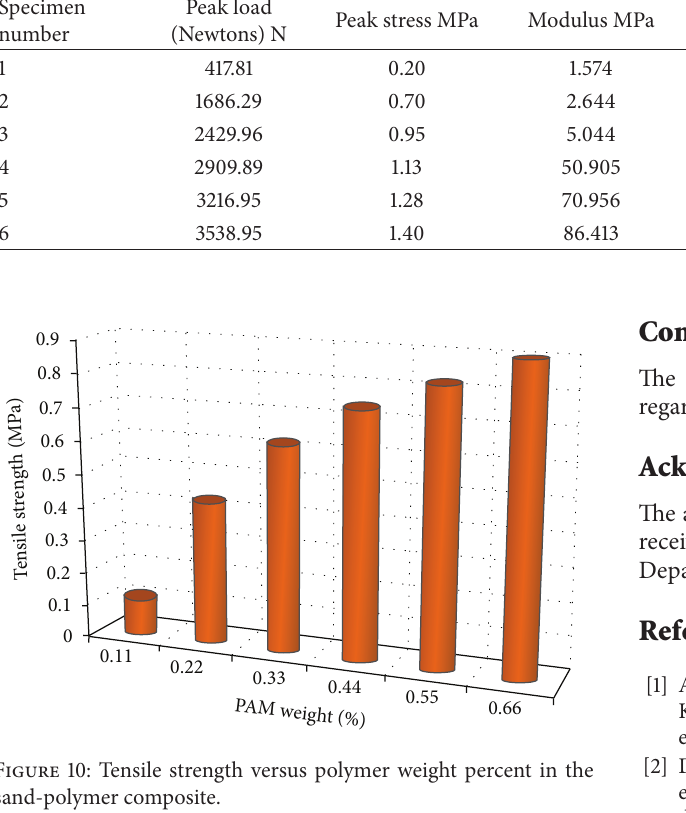
Table 3: Mechanical properties data obtained from the MTS universal testing machine (average of three samples). Specimen